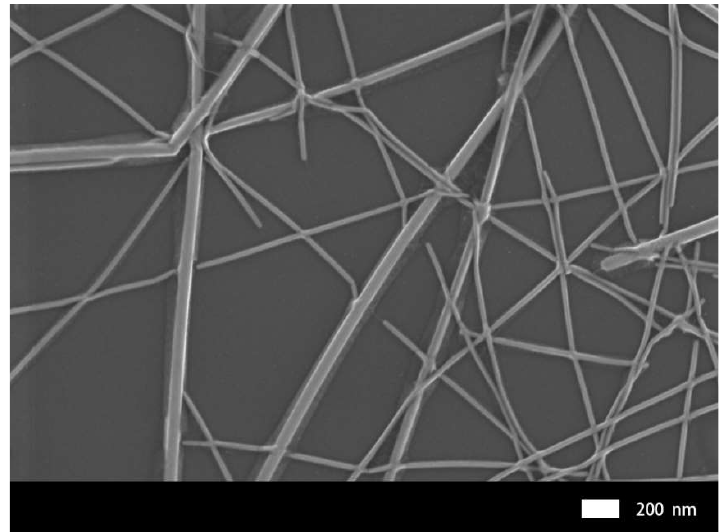
Figure 4. SEM image of SLD-AgNW / graphene films.